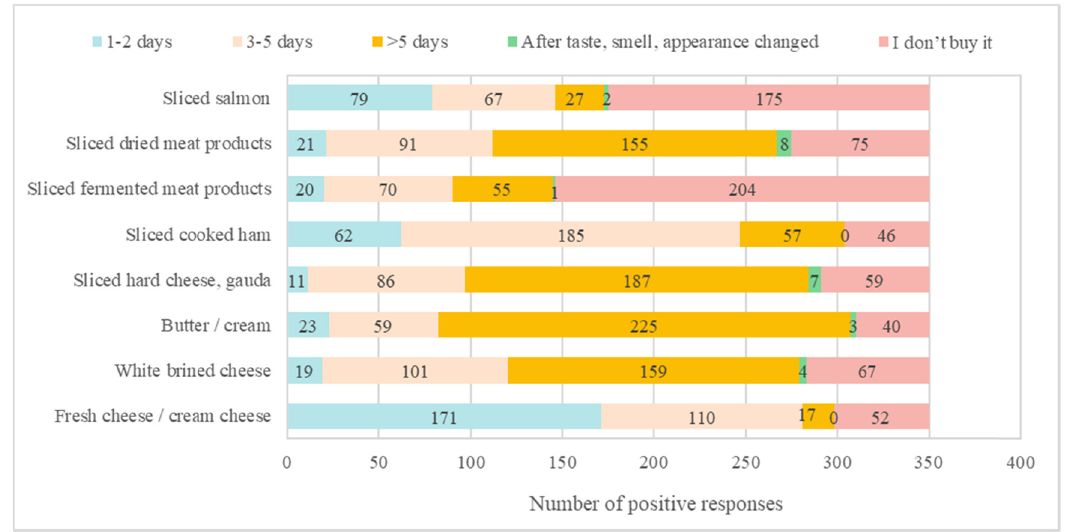
Figure 4: Results to the question “ For how long do you usually store in the refrigerator OPENED pre - packed food items? ” ( The respondents ( N = 350 ) could select only one option )